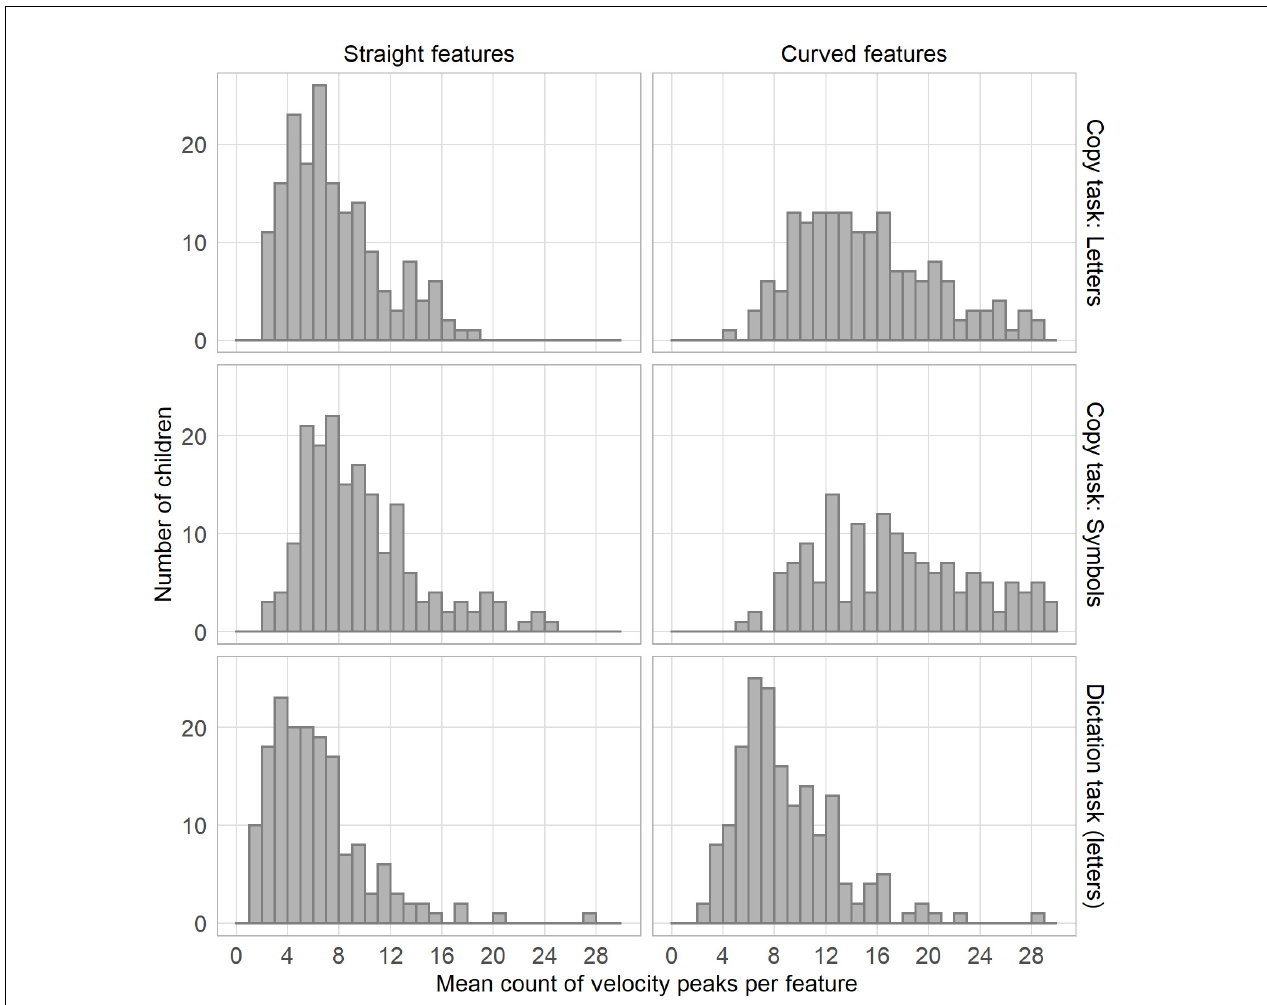
FIGURE A1 | Distribution of velocity